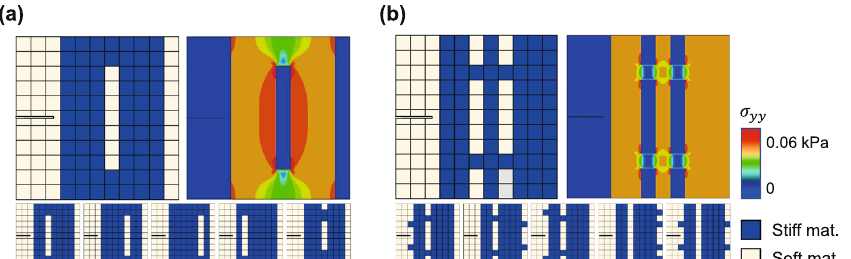
Fig. 6 Optimized composite structures. Top 6 composite structures optimized for maximum ( a ) stiffness and ( b ) strength. The enlarged structures on the top are structures having the highest stiffness and strength value, and the corresponding axial stress ð σ yy Þ distribution is colored at ε yy ¼ 2 : 2727 ´ 10 (cid:2) 5 . The maximum stiffness and strength of composite having optimized microstructures are 1144.7 and 0.16276 MPa, respectively. The fi ve structures having the following highest value of stiffness and strength are represented